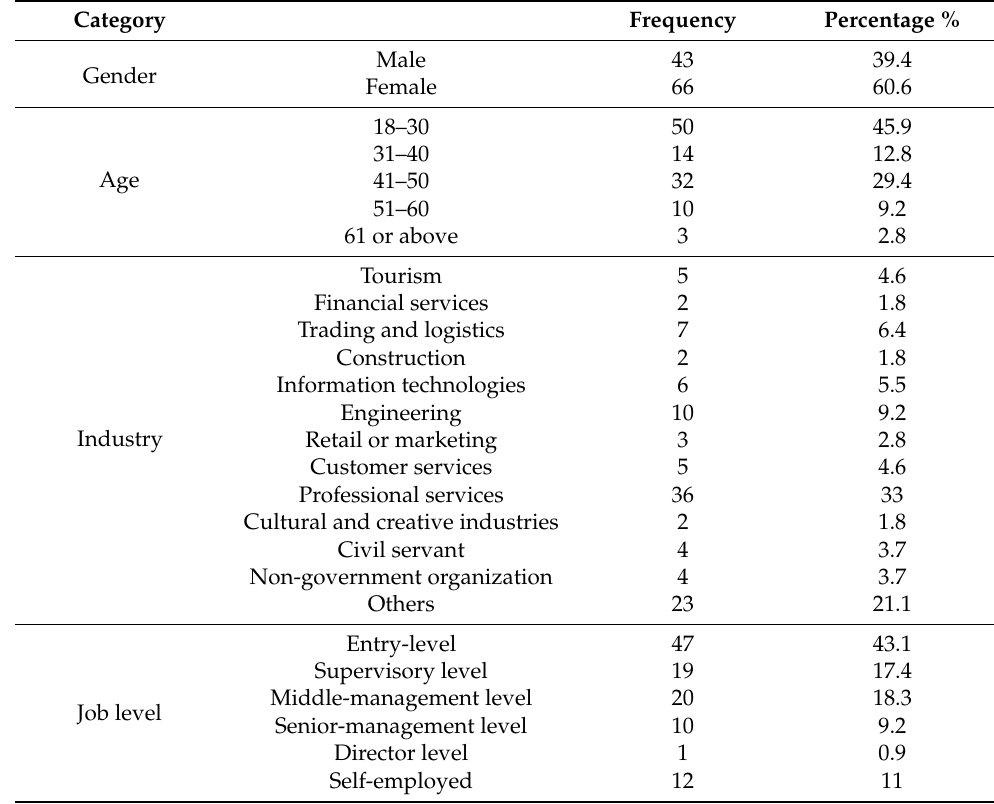
Table 1. Demographic data of